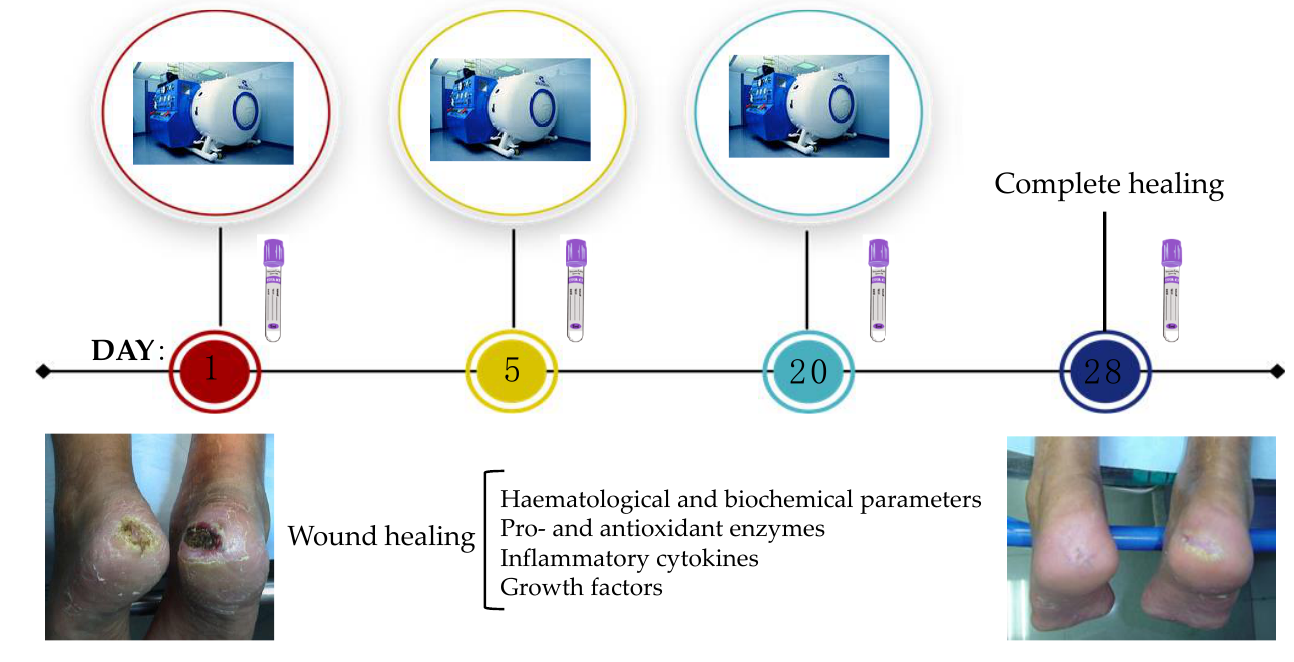
Figure 4. Scheme of the experimental procedure and the main parameters determined during the wound healing process.